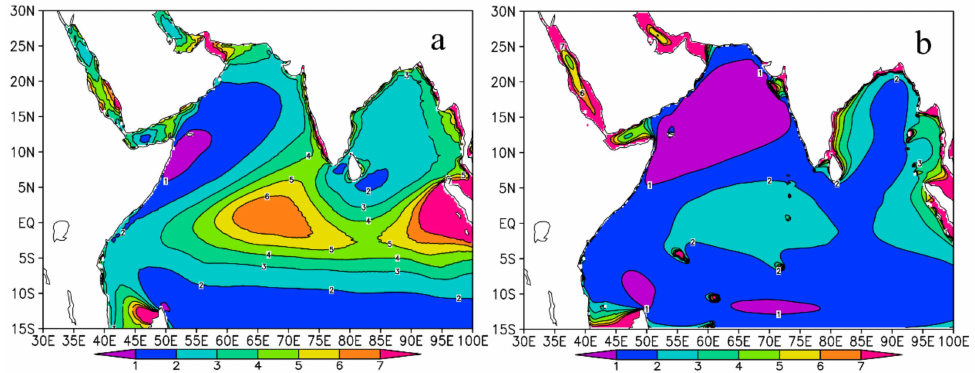
Figure 12. Seasonal Variability Index of wind energy density ( a ) and wave energy density ( b